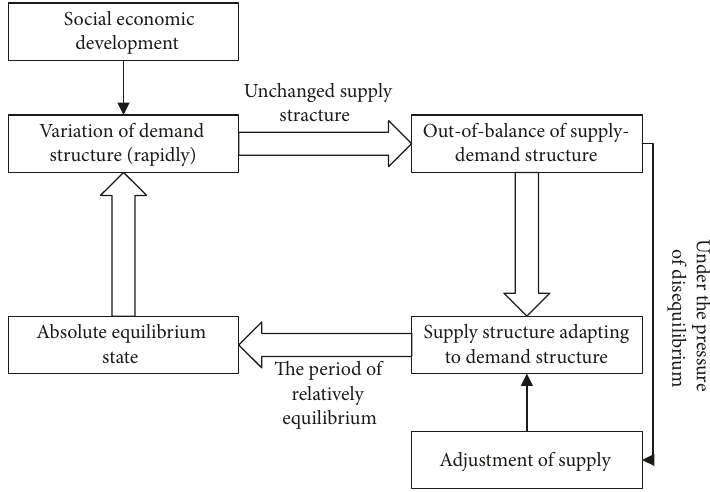
Figure 1: The transition of supply and demand structure